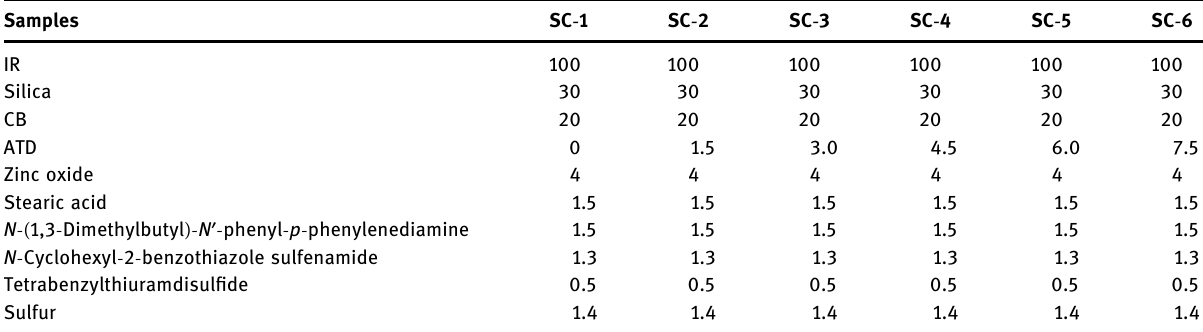
Table 1: Formulation ( mass ratio ) of modi fi ed IR/silica/CB compounds Samples